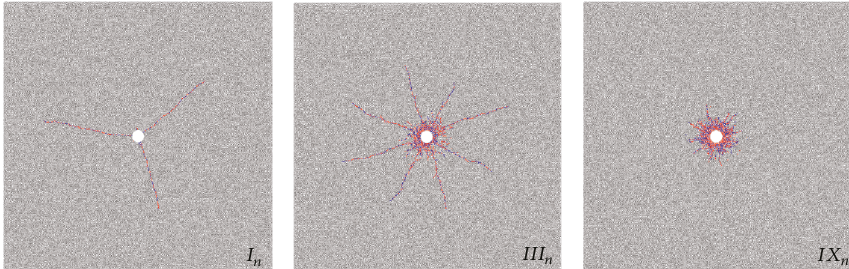
Figure 11: Crack propagation under repeated-impacts of HWSWs with same characteristics.